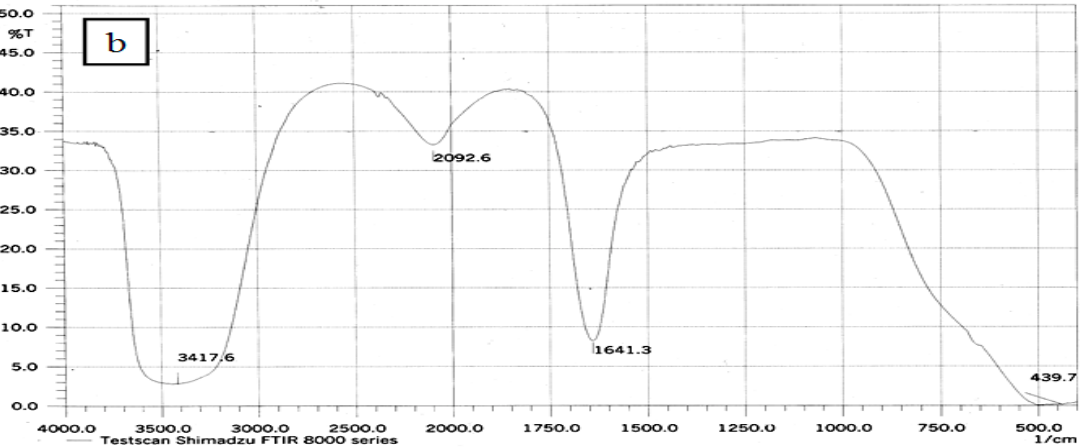
Figure 4. FTIR spectra of TiO 2 NPs synthesized: ( a ) 80 mJ; ( b ) 200 mJ.